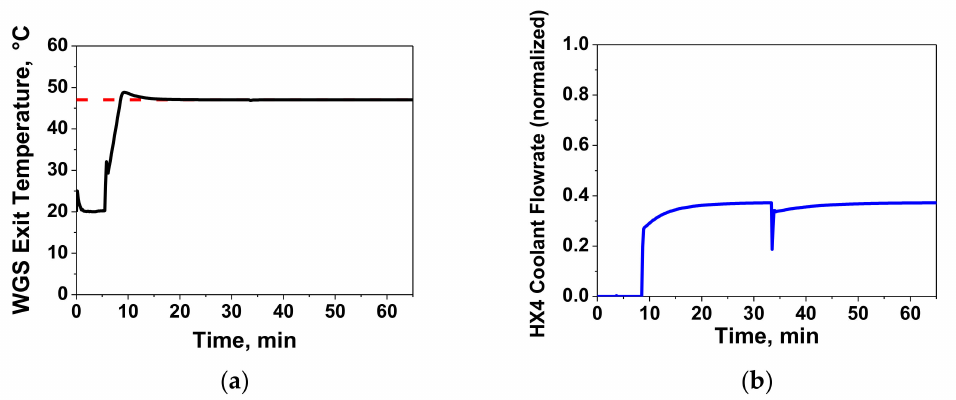
Figure10. ( a )TemperatureprofileoftheWGSexit(TC3controller)and( b )coolantflowratemanipulation at the HX4.